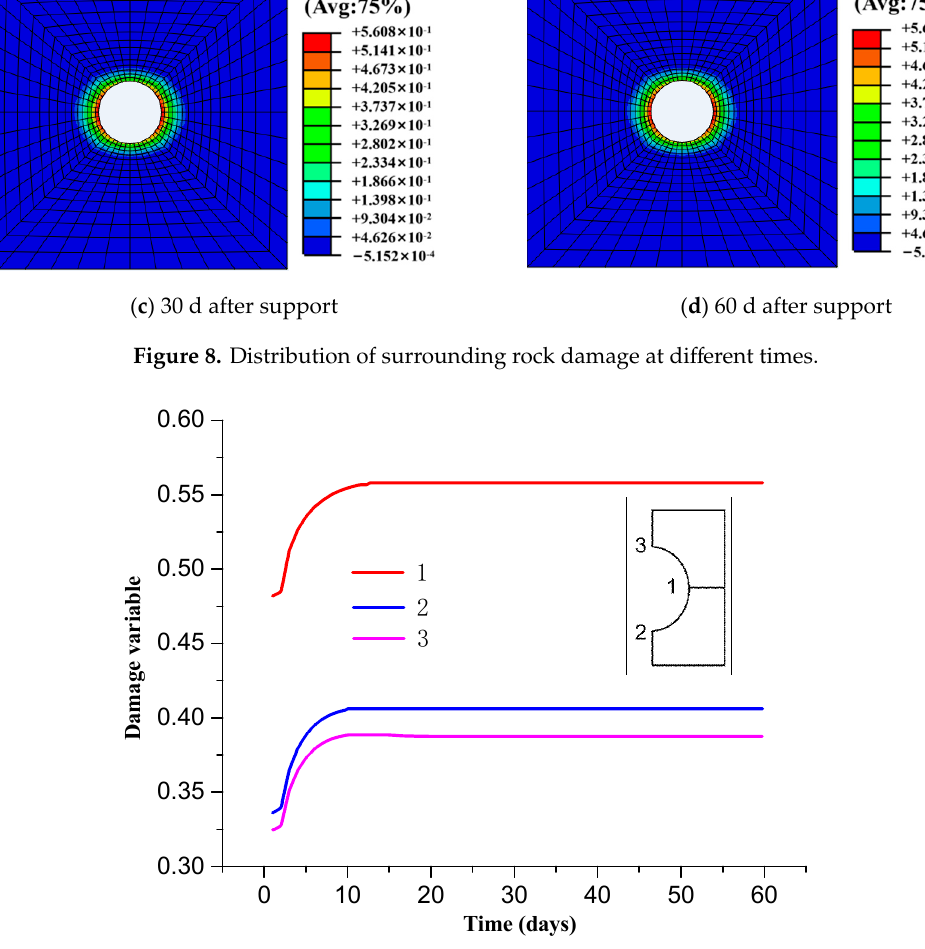
Figure 10. Distribution of surrounding rock damage at different locations in the roadway.